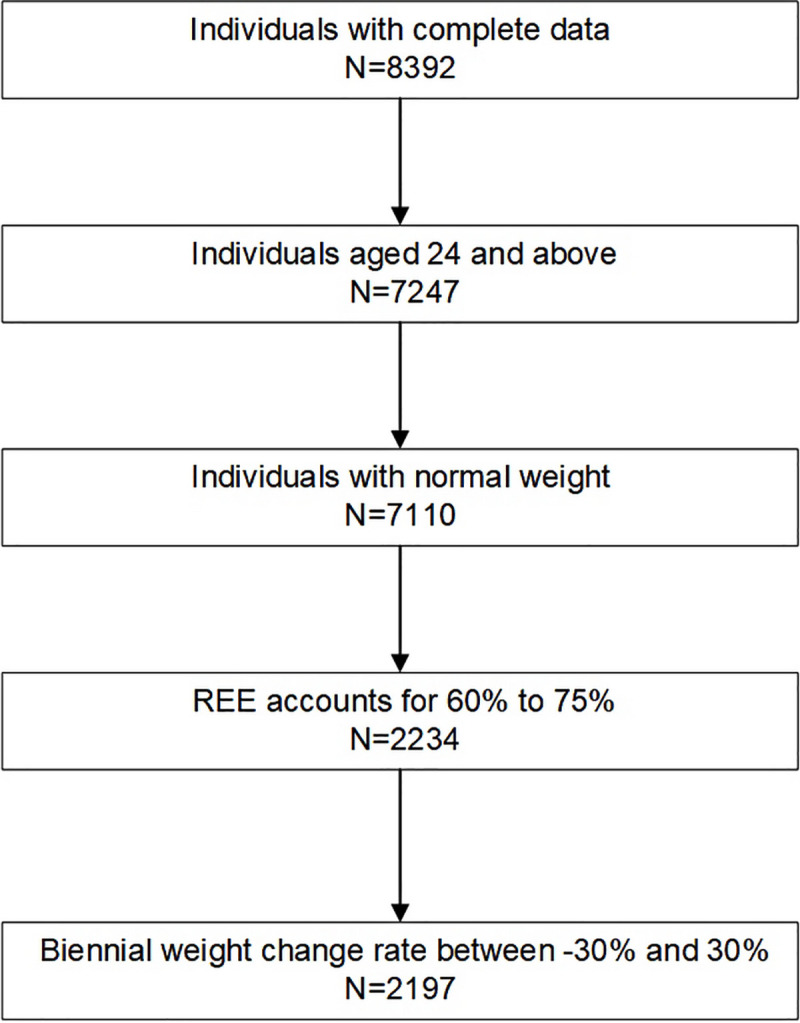
The selection process of simulated agents.Individuals with complete and reasonable data are included. REE, resting energy expenditure.